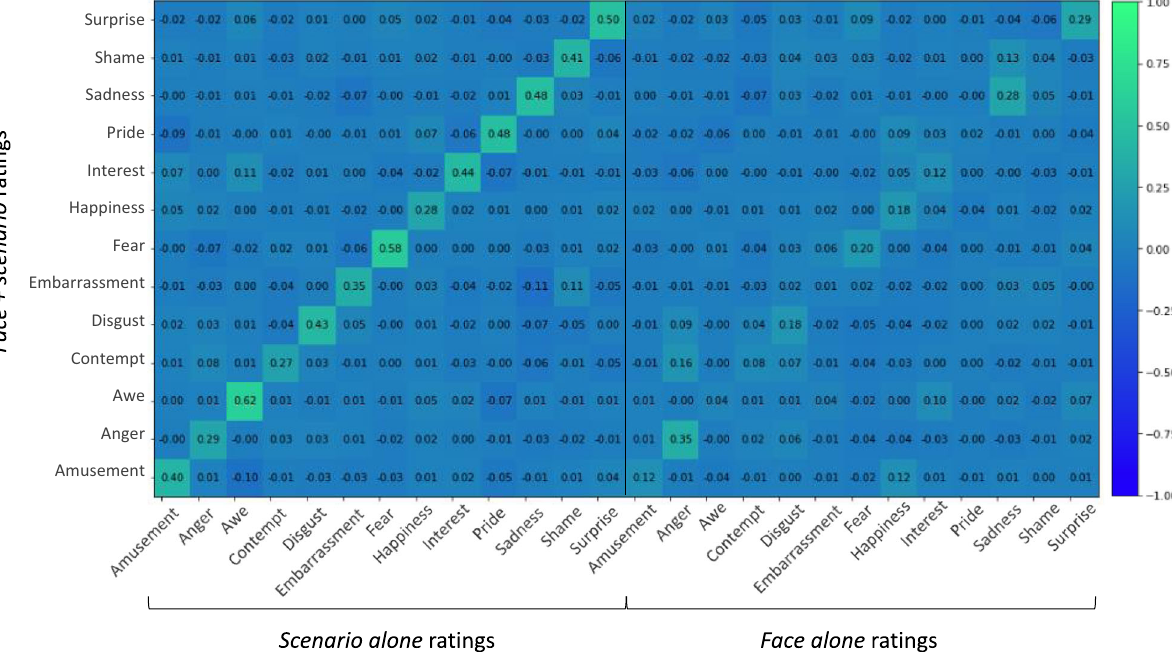
Fig. 4 Semi-partial regression coef fi cients of predictors for face + scenario ratings. Semi-partial regression coef fi cients for median scenario alone ratings (columns in the left matrix) and face alone ratings (columns in the right matrix) when regressed against face + scenario ratings (rows). As indicated by the color bar at the right of the fi gure, more positive coef fi cients appear in shades of green, whereas neutral and more negative coef fi cients appear in shades of blue. Source data are provided as Source Data fi